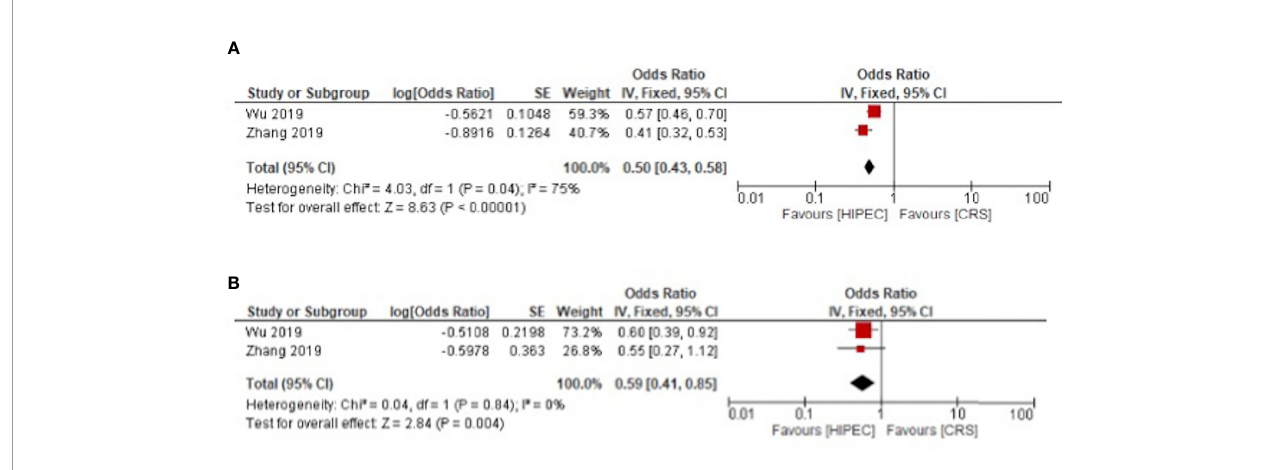
FIGURE 4 | HIPEC + CRS versus CRS progression free survival forest plots (A) primary ovarian cancer (B) recurrent